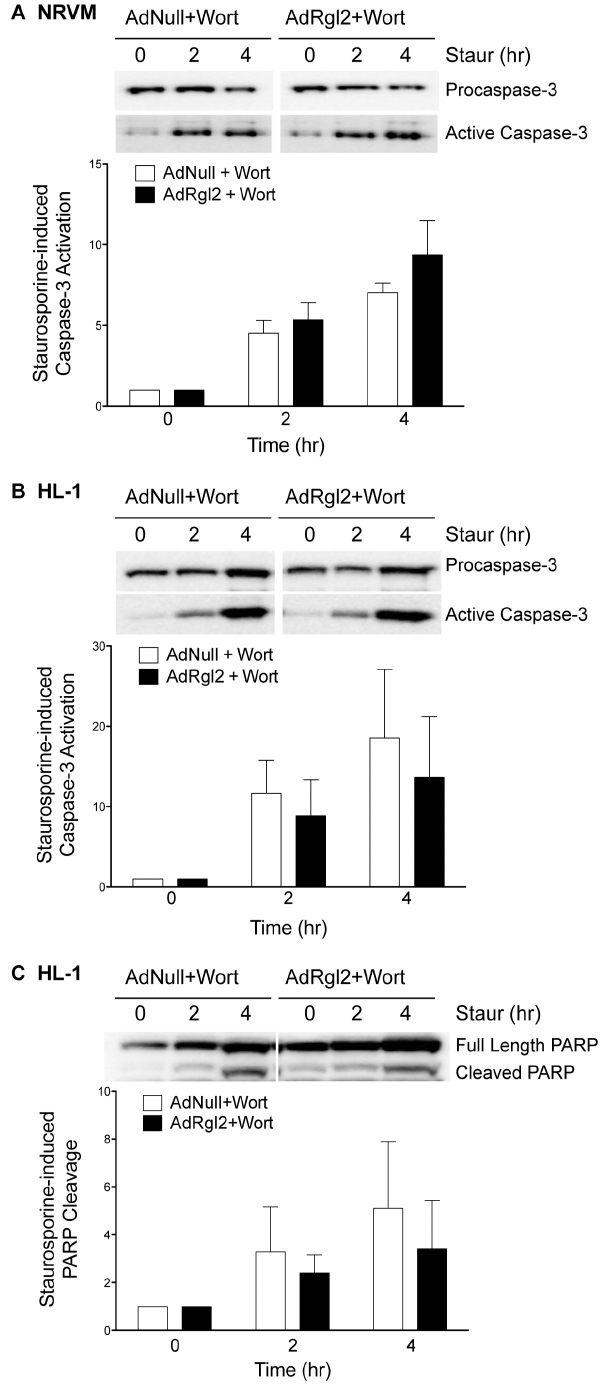
Figure 7. Effect of Rgl2 on staurosporine-induced caspase-3 and PARP cleavage. AdNull- and AdRgl2-infected NRVM ( A ) and HL-1 cardiomyocytes ( B and C ) were pretreated with vehicle or 200 nM wortmannin (Wort) for 30 min followed by exposure to 1 m M staurosporine (Staur) for 0, 2, and 4 hr. Caspase-3 ( A and B ) and PARP ( C ) cleavage were analyzed as described in Figure 5. Results are presented normalized to the respective baseline value (0 hr Staur). Values are expressed as mean 6 SEM of at least 3 separate experiments. * denotes significant difference from AdNull infected cells.